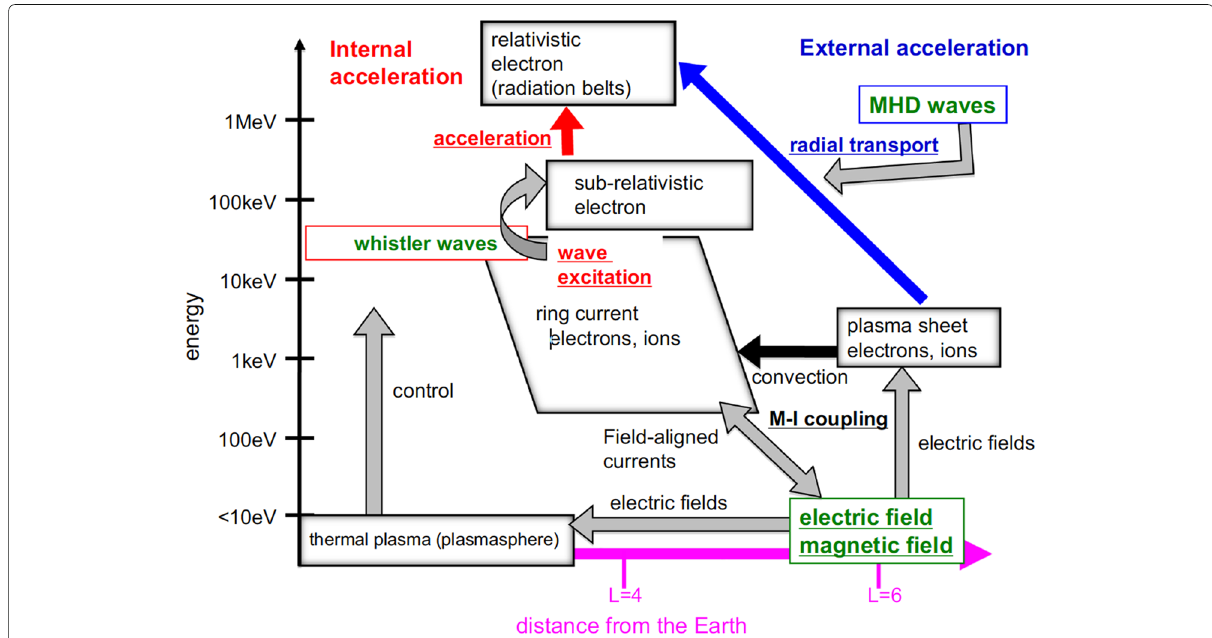
Fig. 5 Diagram illustrating the interconnectedness and cross-scale coupling between particles, waves, and underlying physical processes (reproduced from Miyoshi et al. (2018)). The energy and spatial scales are indicated on the ordinate and abscissa, respectively. The processes and coupling are shown as colored